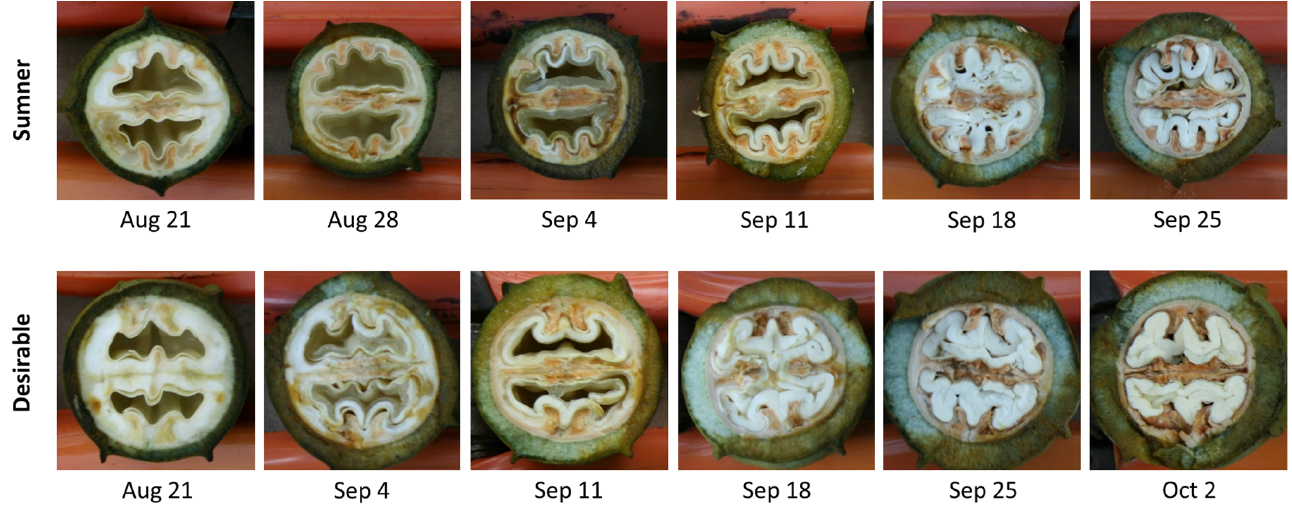
Figure 1. Representative images of Sumner and Desirable pecan nut samples collected at the indicated time points. August 21—water stage, August 28—initiation of gel stage, September 4—gel stage, 25—dough stage transitioning to mature, and October 2—mature kernel, shell hardening complete, awaiting shuck